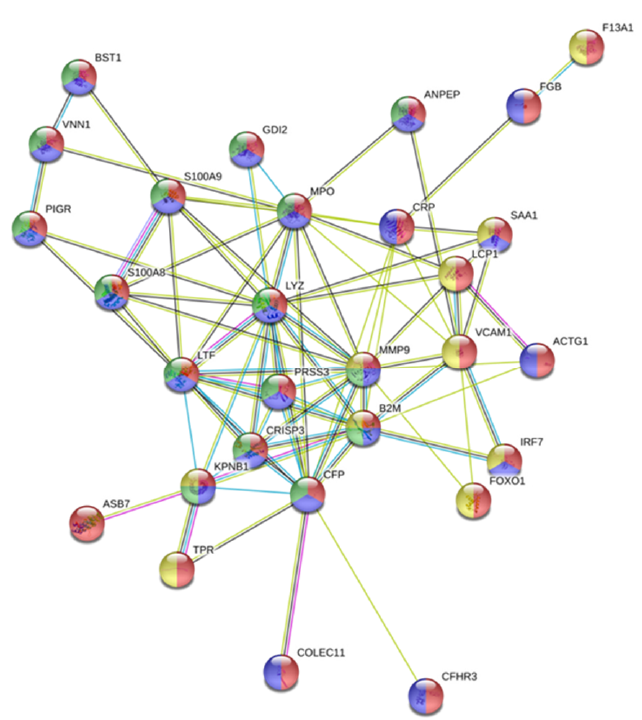
Figure 3. The cluster found in the protein–protein interaction network map of the 194 genes encoded di ff erentially proteins identified in the AuNP–protein corona after the interaction of AuNPs (10.02 ± 0.91 nm) (30 min, incubation) with serum samples belonging to 42 breast cancer patients. Based on the STRING database, 29 di ff erential expressed proteins formed a network core with proteins of the immune system, of which some of them are neutrophil-derived granule proteins. The meaning of the di ff erent edge colors is related to the reactome pathways. Red: immune system; blue: innate immune system; yellow: cytokine signaling in the immune system, green: neutrophil degranulation. Several proteins that are components of neutrophil granules have been related to cancer progression and they may be promising candidate therapeutic targets in states of tumor development and / or chronic inflammation [45]. Upon cell activation, these proteins are exposed at the cell surface or released to the extracellular medium